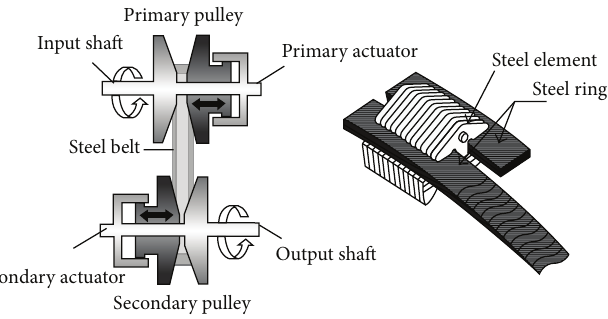
Figure 1: Model of Van Doorne’s CVT and metal pushing V-belt